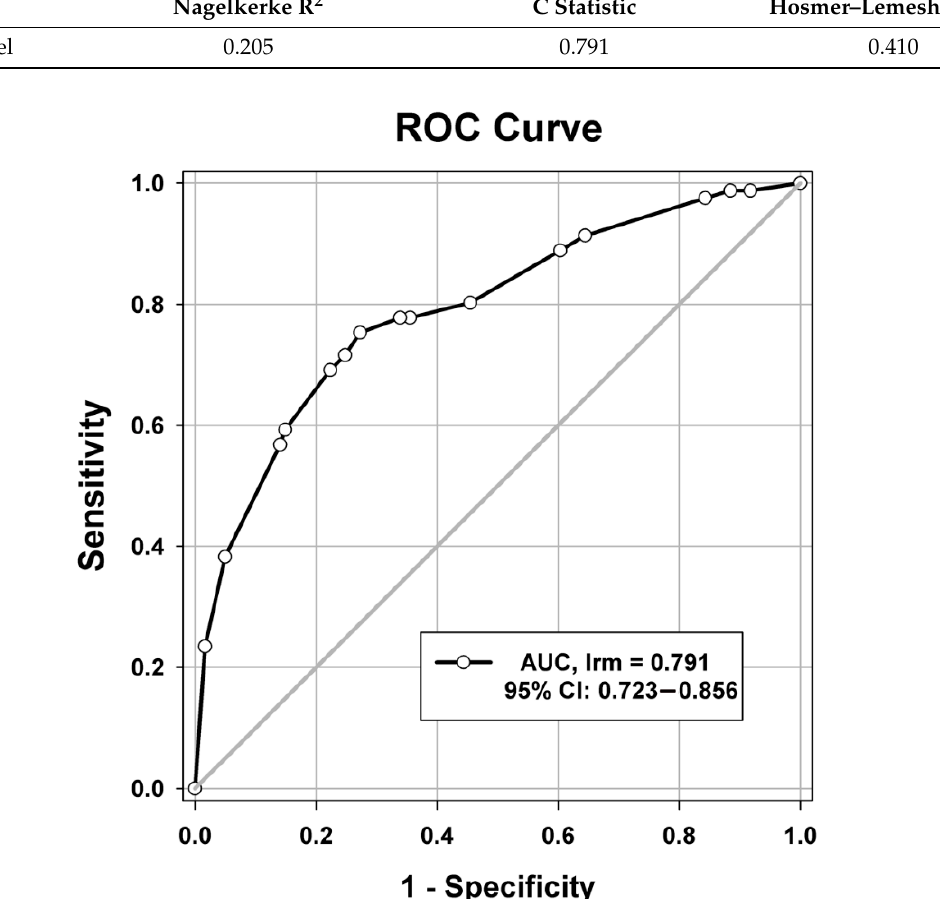
Figure 4. Calibration of the risk prediction model.